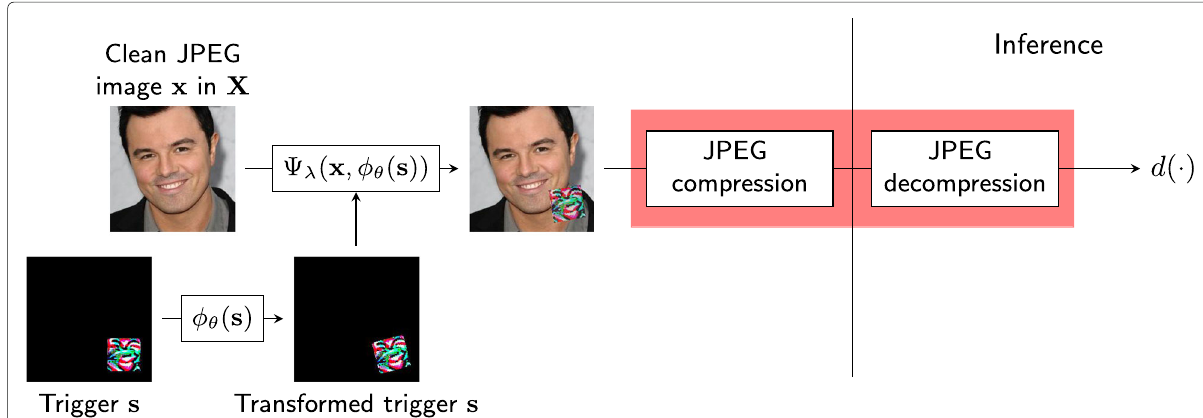
Fig. 3 Block diagram of the trigger embedding and inference pipeline including lossy